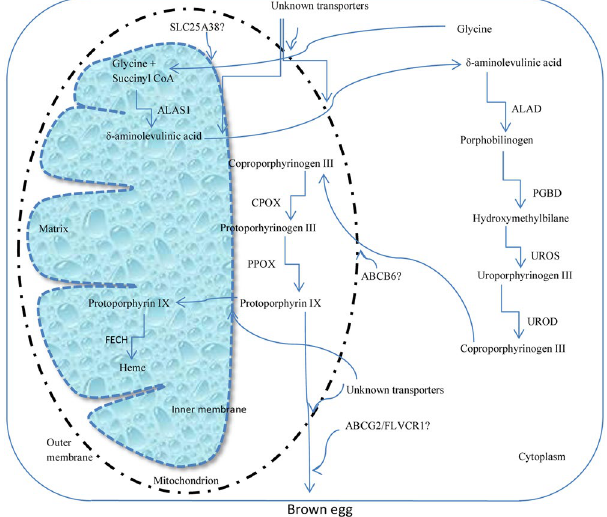
Figure 1. Schematic representation of protoporphyrin IX biosynthetic pathway in the shell gland of brown egg laying hens. Glycine is transported from the cytosol to the matrix of mitochondria through the possible transporter SLC25A38. Succinyl coenzyme A and glycine are oxidized by aminolevulinic acid synthase 1 (ALAS1) to δ -aminolevulinic acid, which is transported back to the cytosol through unknown transporter/s. The δ -aminolevulinic acid is converted into porphobilinogen through the action of aminolevulinic acid dehydratase (ALAD). The porphobilinogen is further reduced into hydroxymethylbilane through porphobilinogen deaminase (PGBD). In the next two steps, uroporphyrinogen III and coproporphyrinogen III are synthesized through